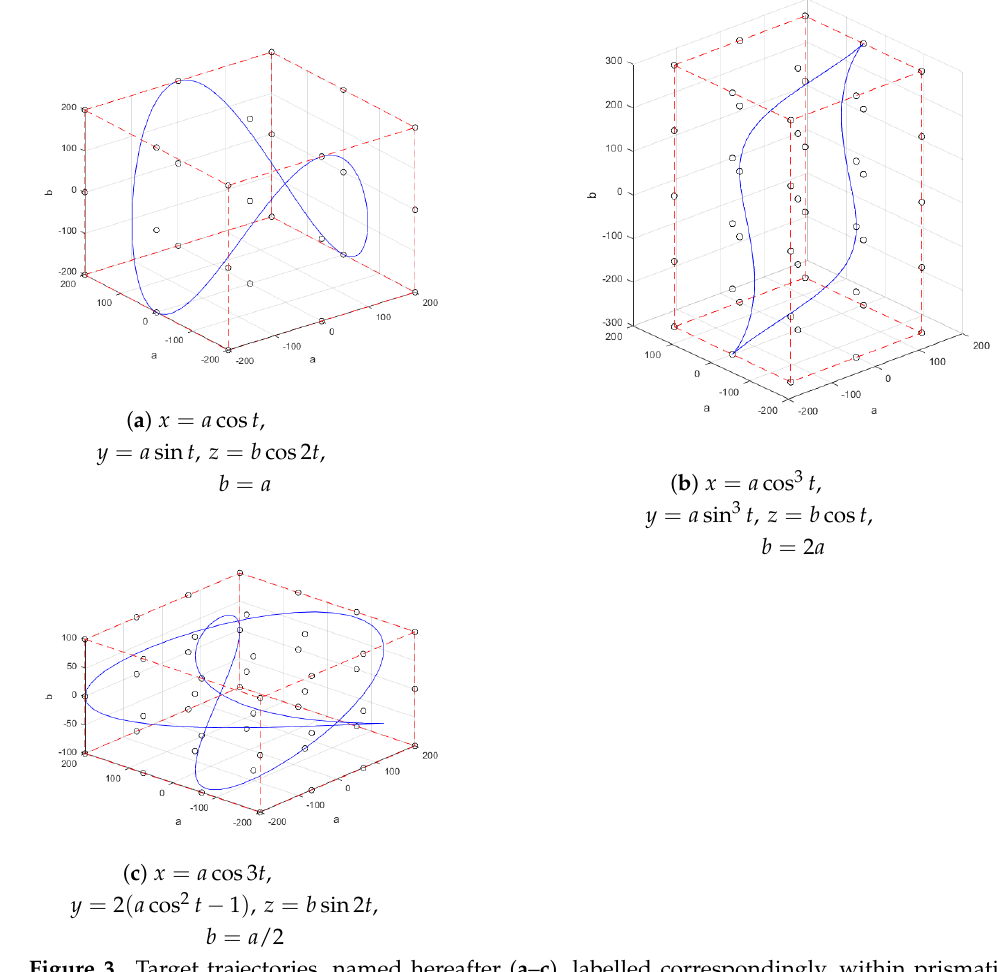
Figure 3. Target trajectories, named hereafter ( a – c ), labelled correspondingly, within prismatic bounding boxes, and points of the discretized